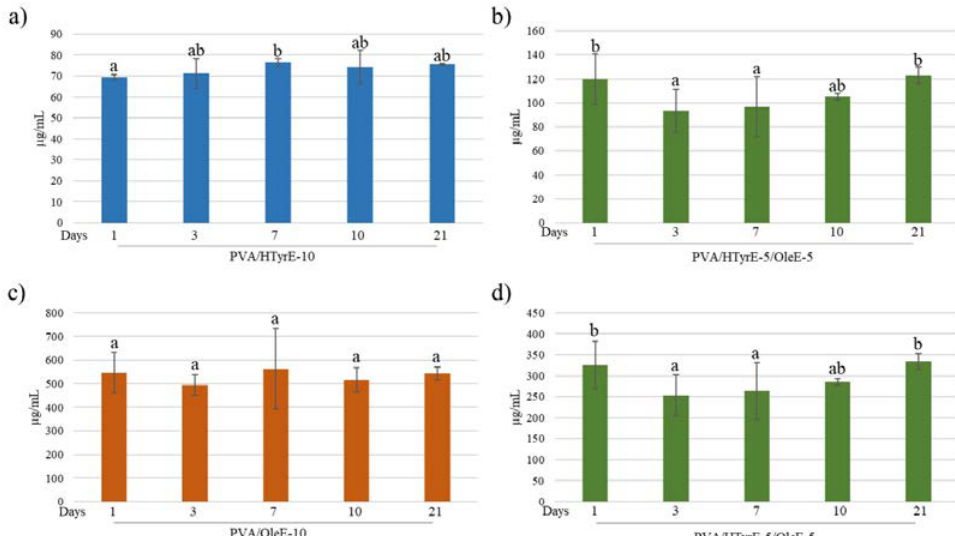
Figure 10. ( a , b ) HTyr and ( c , d ) Ole released ( µ g/mL) from each formulation (PVA/HTyrE-10, PVA/OleE-10 and PVA/HTyrE-5/OleE-5) into the simulant solution at different contact times. Analysis have been carried out in a food simulant (ethanol 10% v / v ) for 21 days. Significant differences for p ≤ 0.05 were evidenced performing Tukey HSD test and are indicated with different letters.